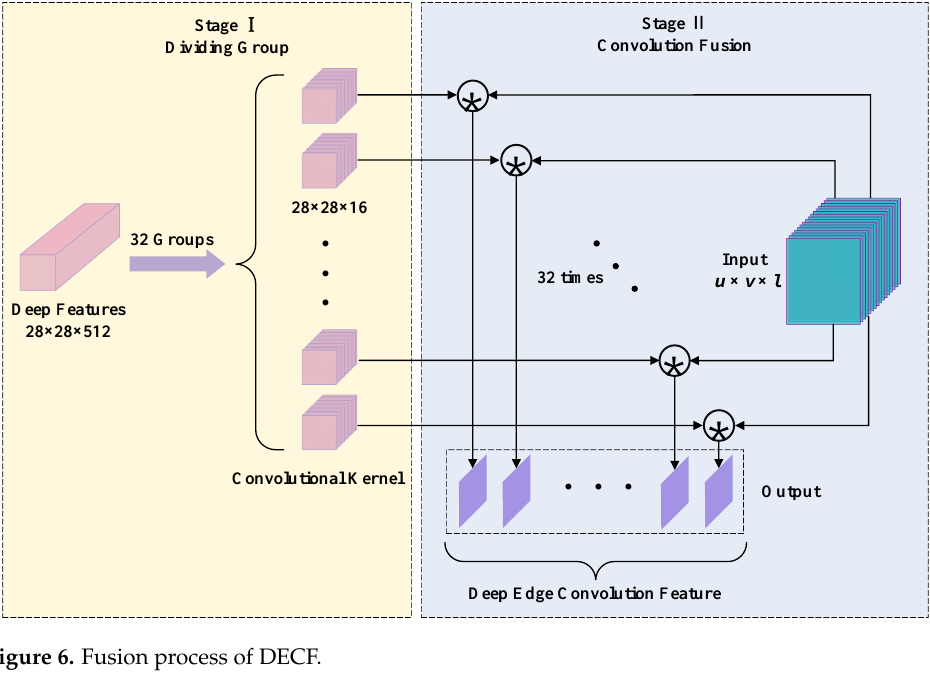
Figure 6. Fusion process of DECF.